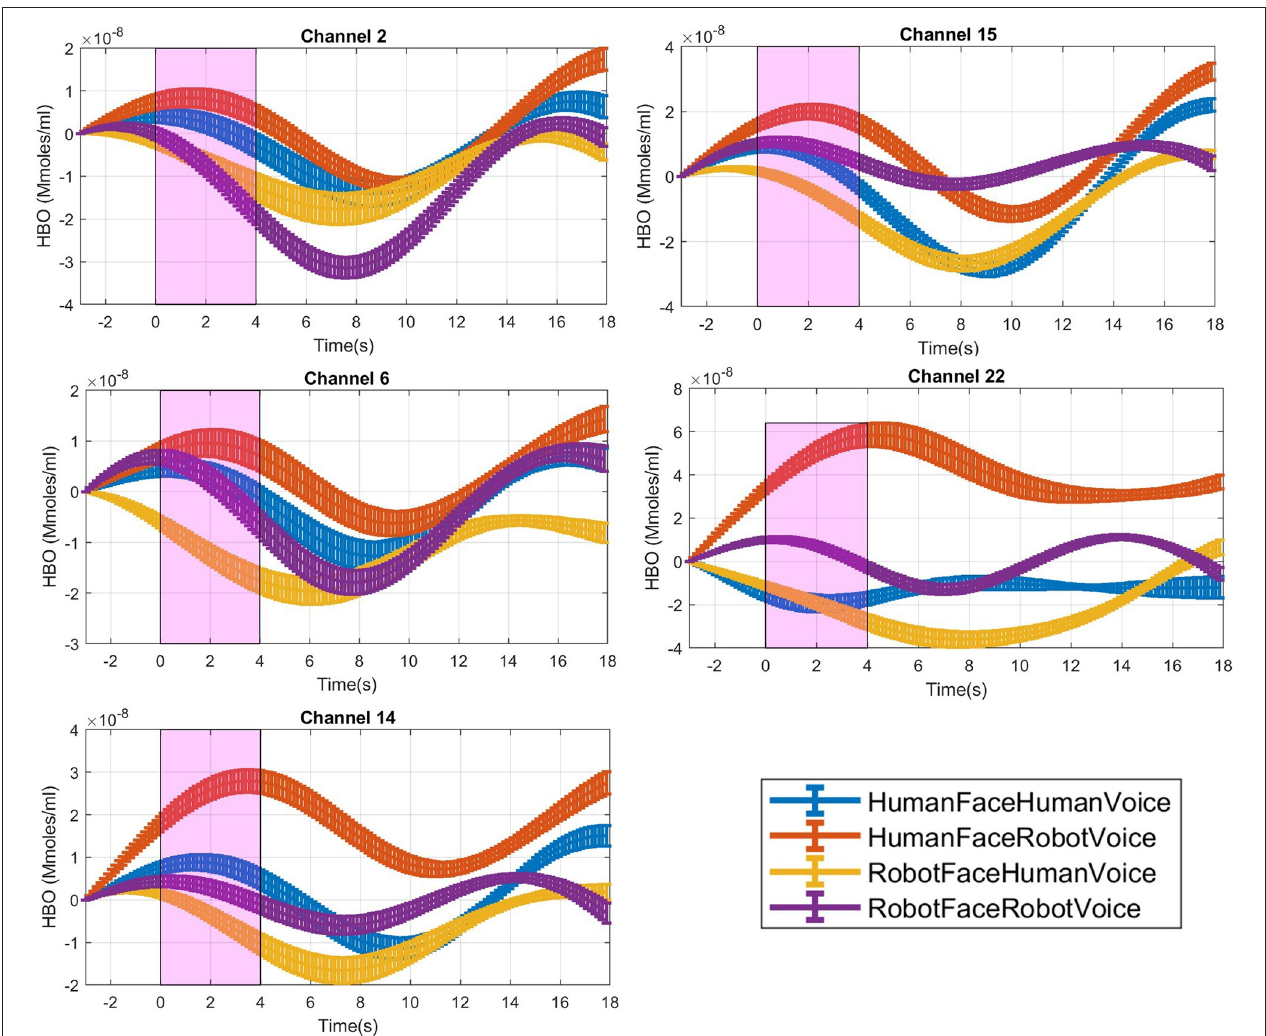
FIGURE 3 | Time traces of block averaged 1 [HbO] signals of each audiovisual stimuli in representative channels, averaged across all subjects. 1 [HbO] resembles the relative concentration change of HbO in micromoles at probed brain tissue. Each time trace indicates block average of HbO responses detected during each specific audio-visual stimulus from the same channel of all participants. Pink shaded area represents the audio-visual stimulus interval. Error bars indicate the standard error of the mean signal across participants.